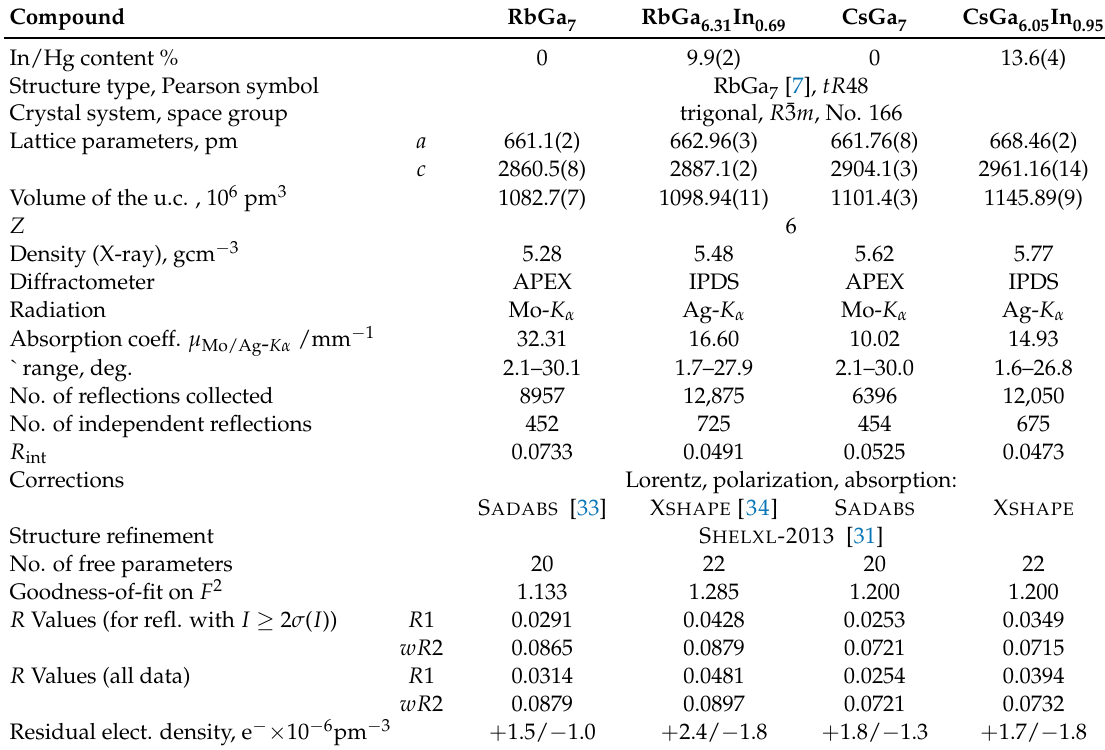
Table 2. Crystallographic data and details of the data collection and structure refinement of the RbGa -type 7